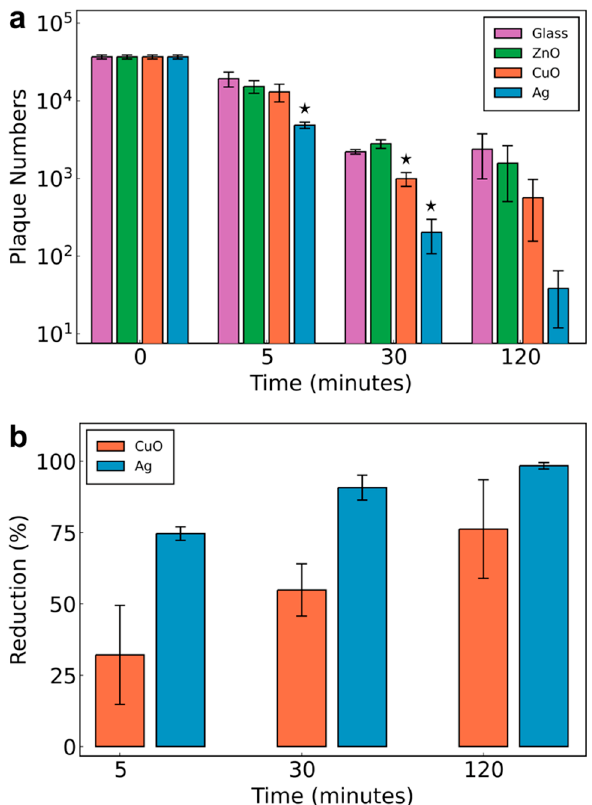
Figure 4. ( a ) SARS-CoV-2 residual viral load as determined by plaque assay on the developed nanocoatings up to 120 min ( n = 3), * p < 0.05, all p -values in Supplementary Materials, Table S1. ( b ) Reduction % of SARS-CoV-2 on CuO and Ag/SiO 2 nanoparticle-coated surfaces as calculated from ( a ); error bars are the standard error of the mean.